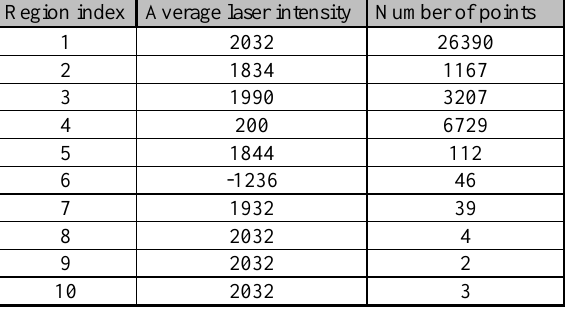
Table 1: Result of the region growing stage by means of the threshold values in figure 7.